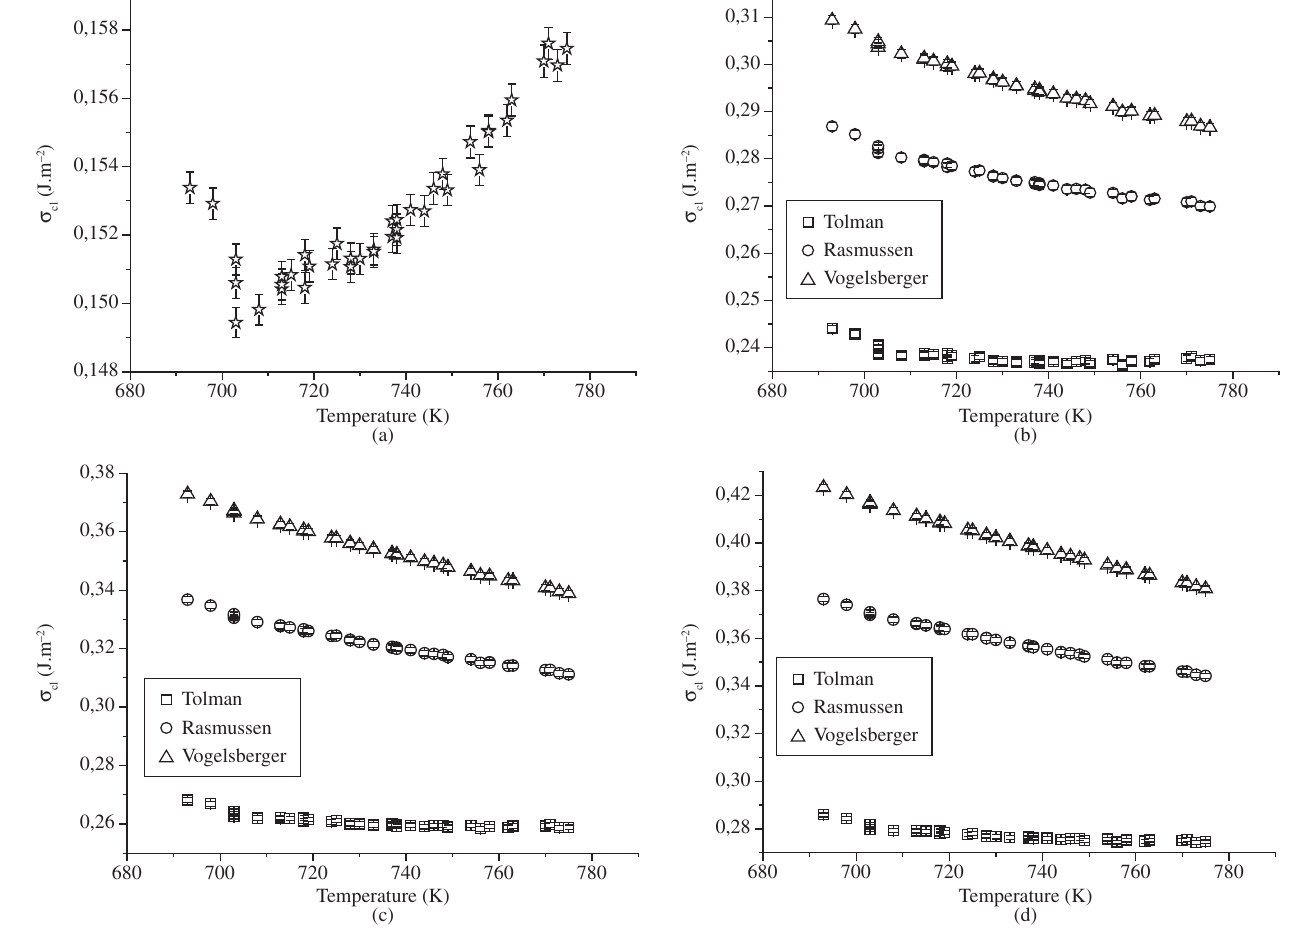
Figure 2. Crystal-melt surface energy as a function of the temperature calculated for a LS ( □ ), Rasmussen ( ○ ) and Vogelsberger (  ). The δ values used were: a) 0; b) 2.33 x 10 –10 m; c) 3 x 10 –10 m; d) 3.5 x 10 –10 m. For δ = 0, the same values of σ were obtained for all decoupling equations. These values are indicated as ( 